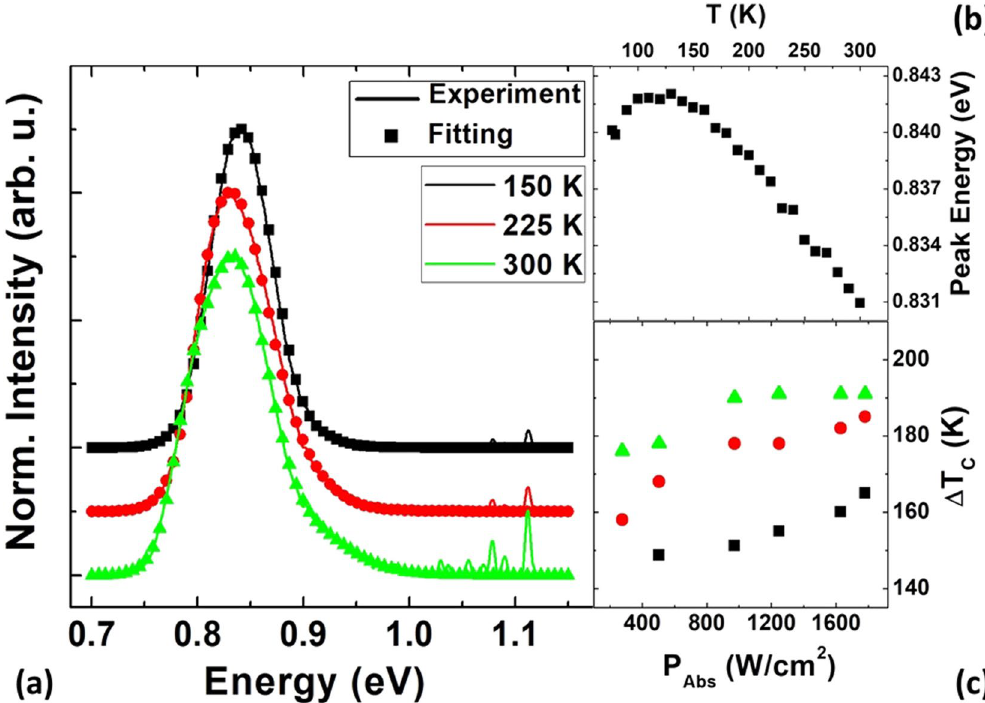
Figure 2. ( a ) Normalized temperature dependent photoluminescence from 77 K to 300 K. ( b ) The peak energy as a function of temperature. ( c ) Extracted carrier temperature differences ( Δ T C ) as a function of absorbed power at 150 K (black squares), 225 K (red circles), and 300 K (green